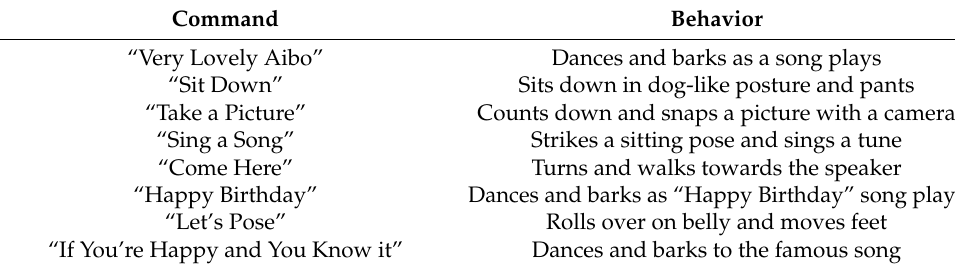
Table 1. Commands and their corresponding behaviors for Aibo.